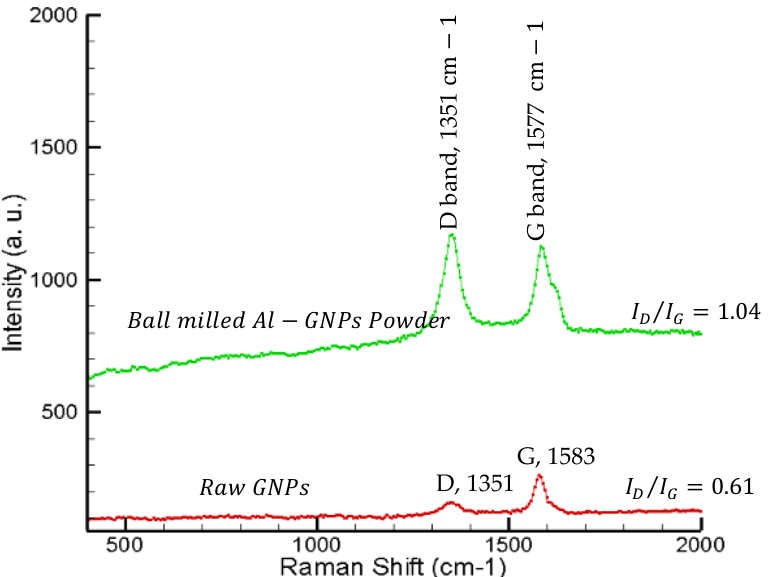
Figure 4. Raman analysis of raw GNPs and ball-milled Al – GNP powder.